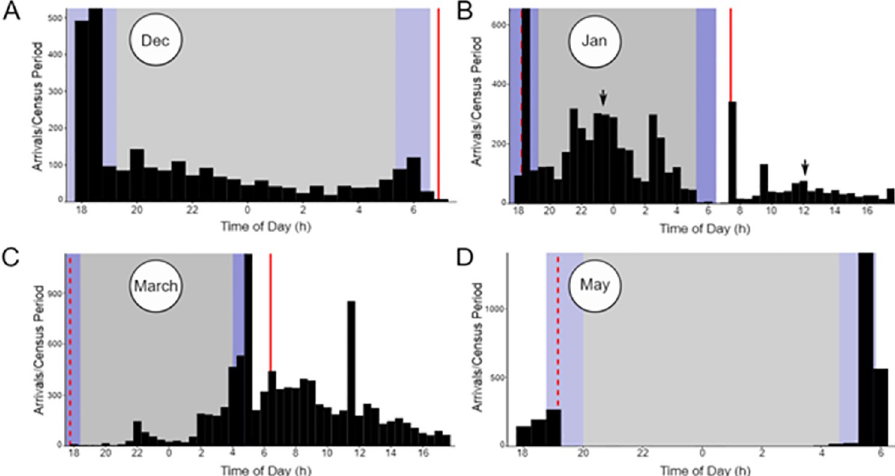
Fig 2. Daily foraging activity patterns of A . dorsata . Daily foraging activity on the days of the (A) December full moon, (B) January full moon, (C) March full moon, and (D) May full moon are shown as representative examples of A . dorsata daily activity patterns. Purple shaded regions indicate twilight, gray shaded regions indicate night, and white indicates daytime. The red dotted line indicates moonrise, while the solid red line indicates moonset. Arrows on the January full moon panel (B) indicate times corresponding to the sample videos provided in the supplementary materials (S1 and S2 Videos). Figures depicting the daily foraging activity for every day of the January–February and March–April lunar cycles can be found in S1 Fig. Data were collected from Colony 3 in December, Colony 4 in January and March, and Colony 5 in